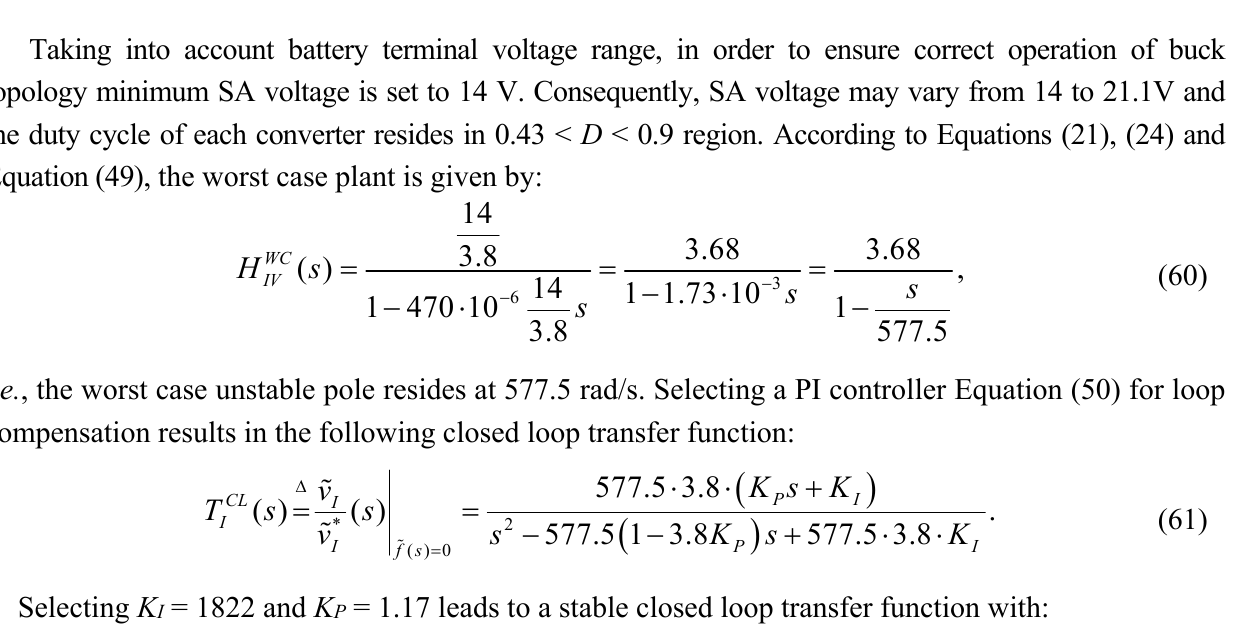
Figure 21. Operation point loss as a result of abrupt irradiation